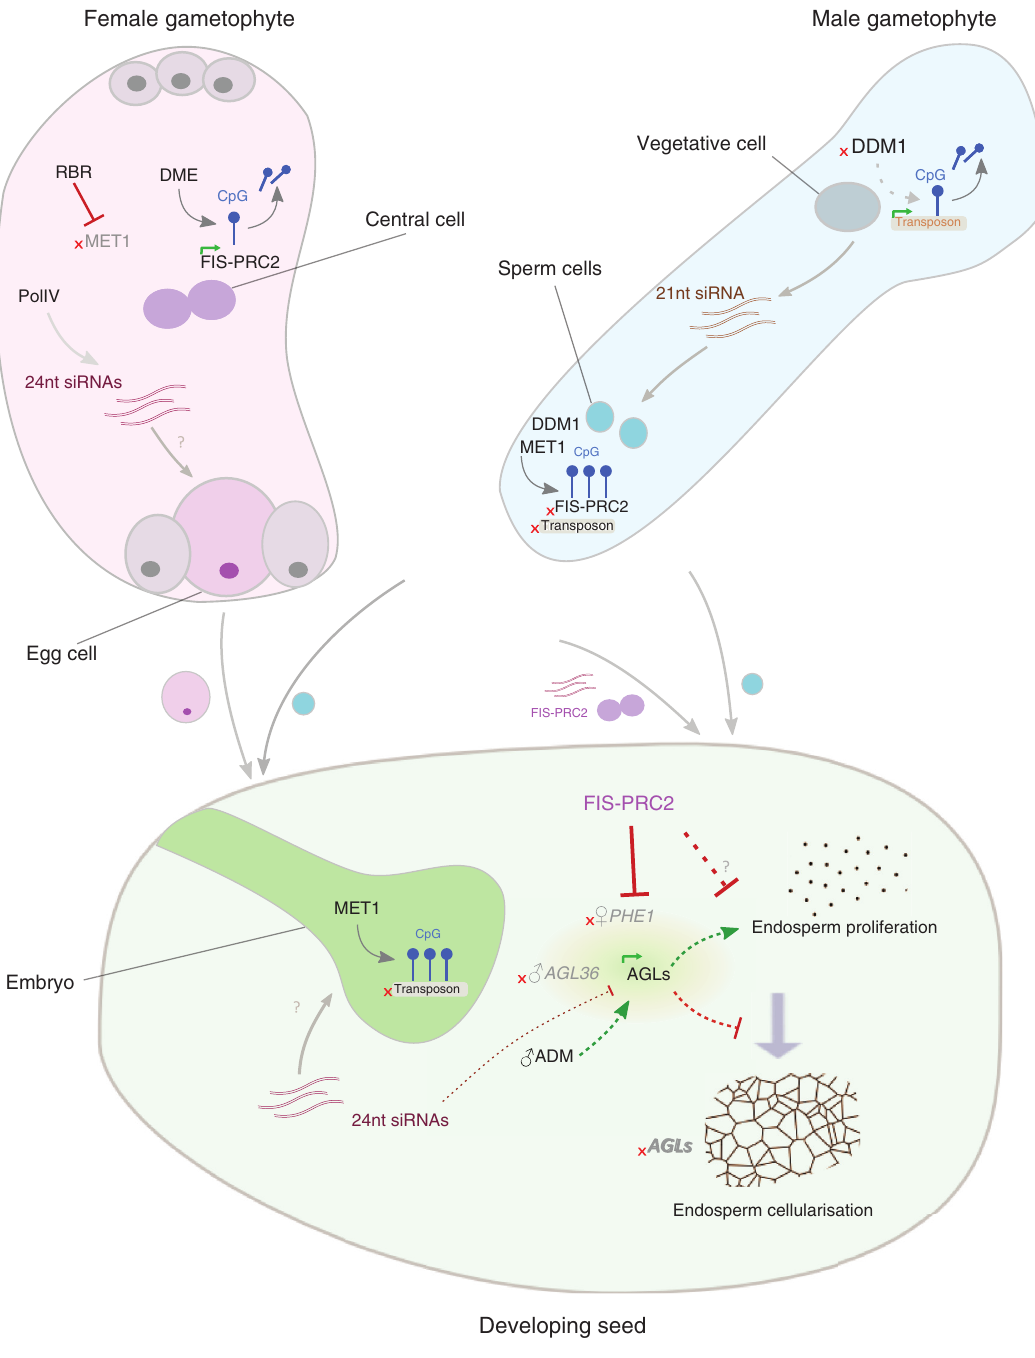
Figure 3 Highly simplified diagram showing the genetic and epigenetic mechanisms that balance paternal and maternal information during gametogenesis and seed